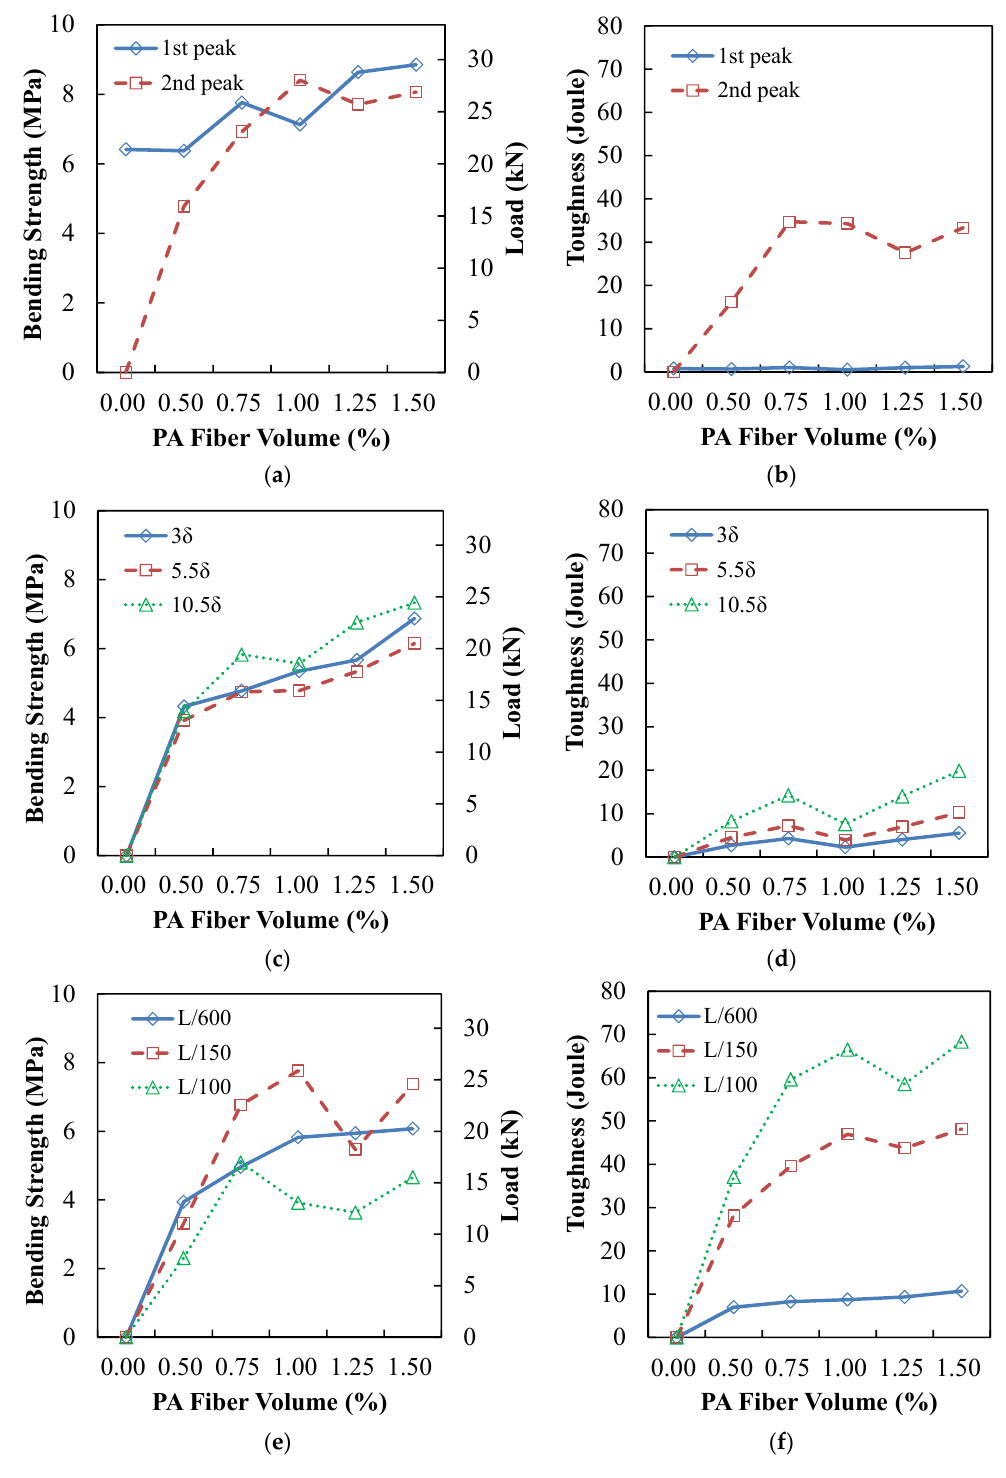
Figure 6 . ( a ) Bending strength (first and second peaks); ( b ) toughness (first and second peaks); ( c ) bending strength (3 δ , 5.5 δ , 10.5 δ ); ( d ) toughness (3 δ , 5.5 δ , 10.5 δ ); ( e ) bending strength (L/600, L/150, L/100); ( f ) toughness (L/600, L/150, L/100).